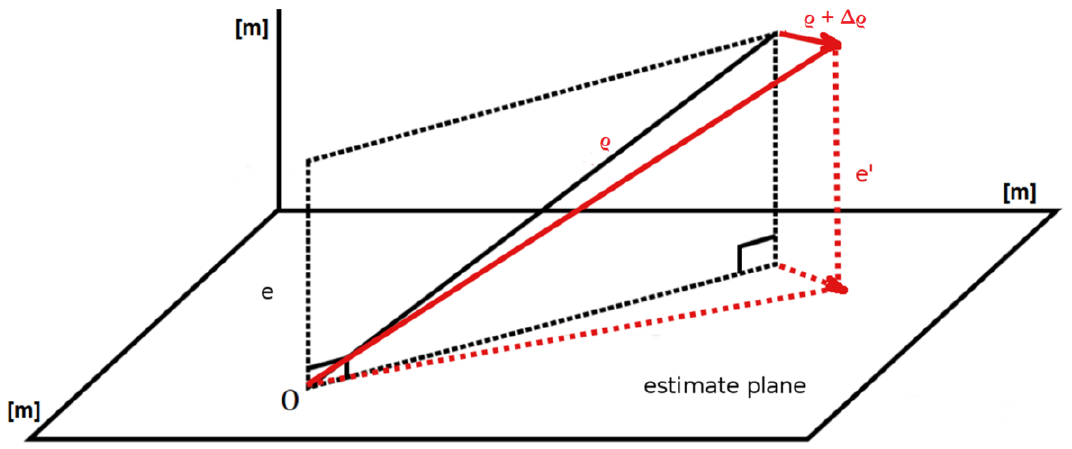
Figure 1. 3D geometric interpretation of least squares. The vector of observations is projected onto the solution plane.